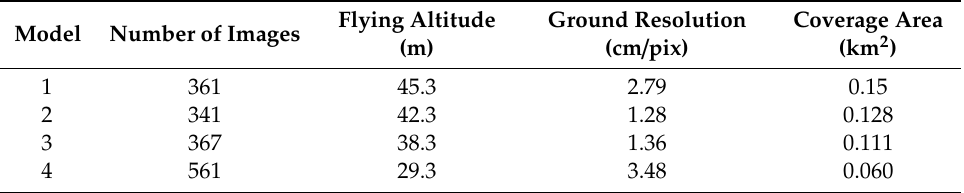
Table 1. Main parameters of the four UAV surveys.